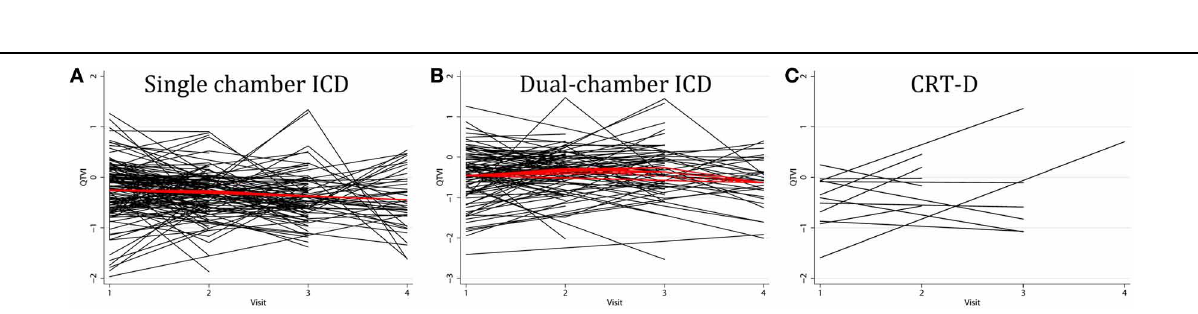
FIGURE 4 | Comparison of population-averaged longitudinal trends in QTVI NF in patients (A) without FVT/VF, and (B) with sustained FVT/VF and appropriate ICD shocks. Scatterplot of QTVI NF at each standardized study visit is shown. Lowess smoother curve shows mean trend in QTVI NF over time.